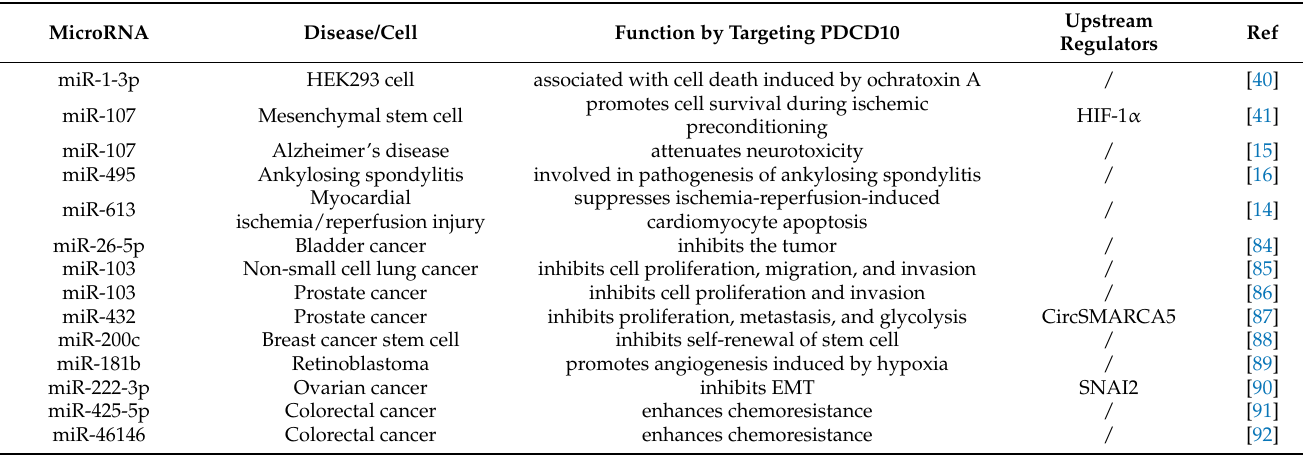
Table 1. MicroRNAs targeting